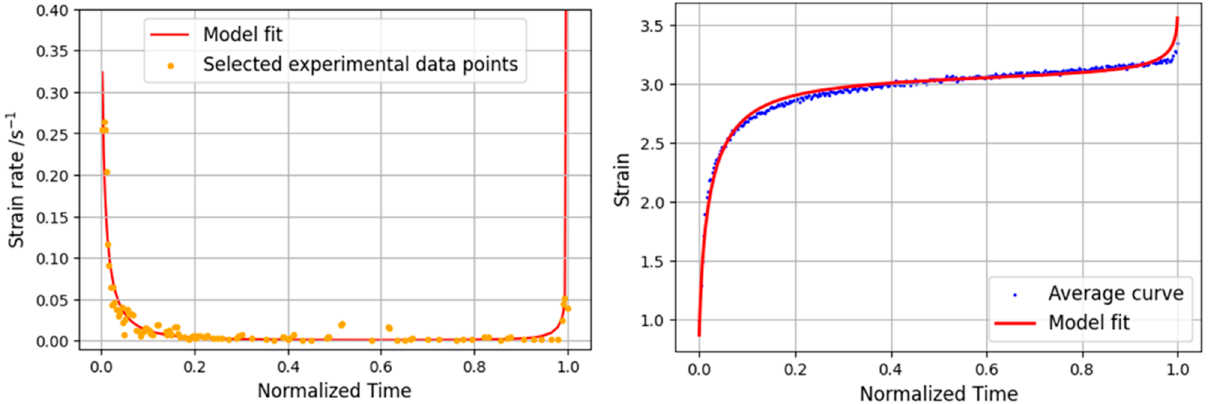
Figure 13. Analytical and experimental strain rate curve ( left ) and static creep curve ( right ) for 60% load level.